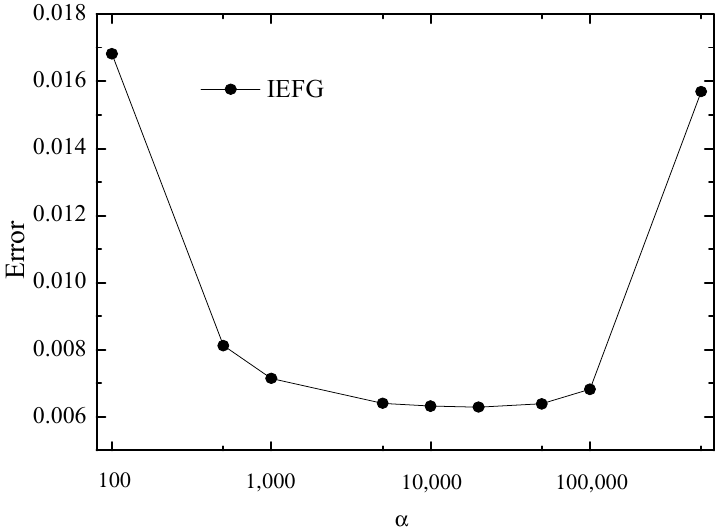
Figure 2. The error of the numerical solutions of the IEFG method with the increase in α .